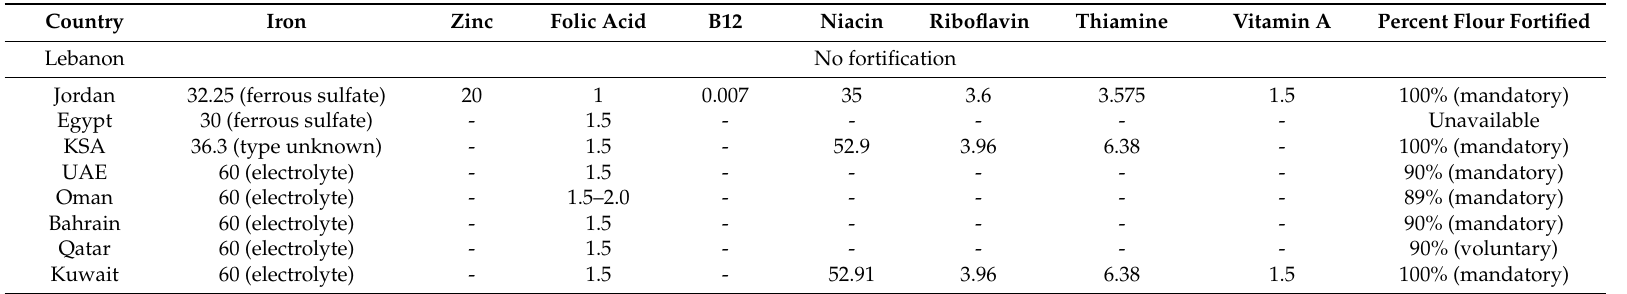
Table 2. Nutrients added for wheat flour fortification (parts per million) a .